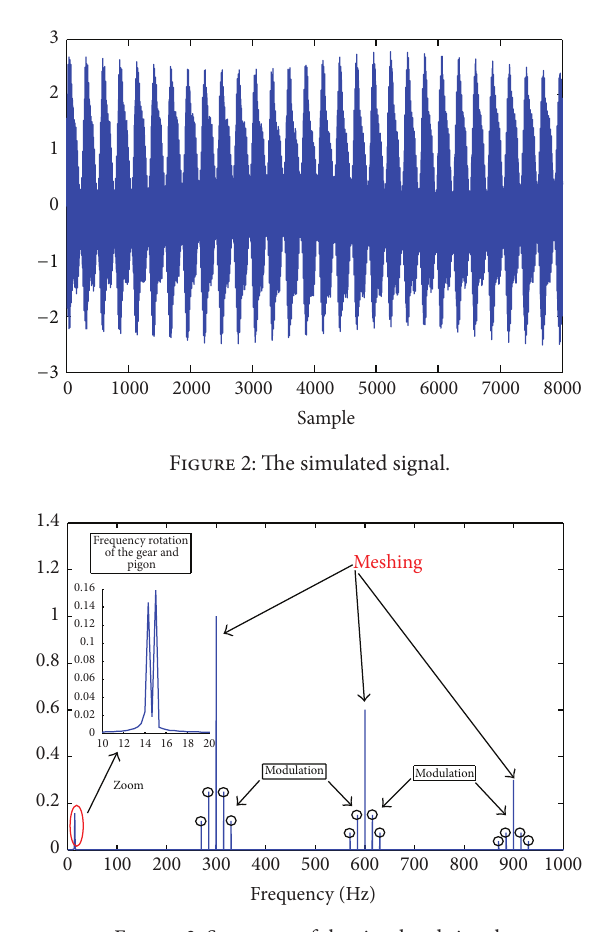
Figure 3: Spectrum of the simulated